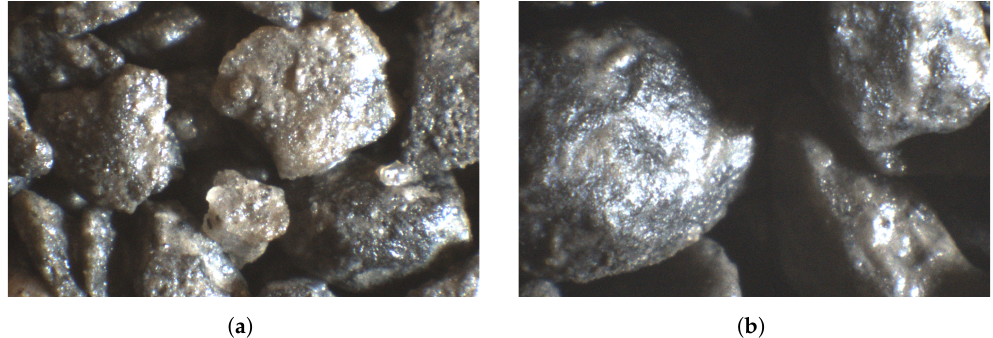
Figure 20. Macro images of samples: ( a ) 0.5–1 mm with 7% moisture; ( b ) 1–2 mm with 5%